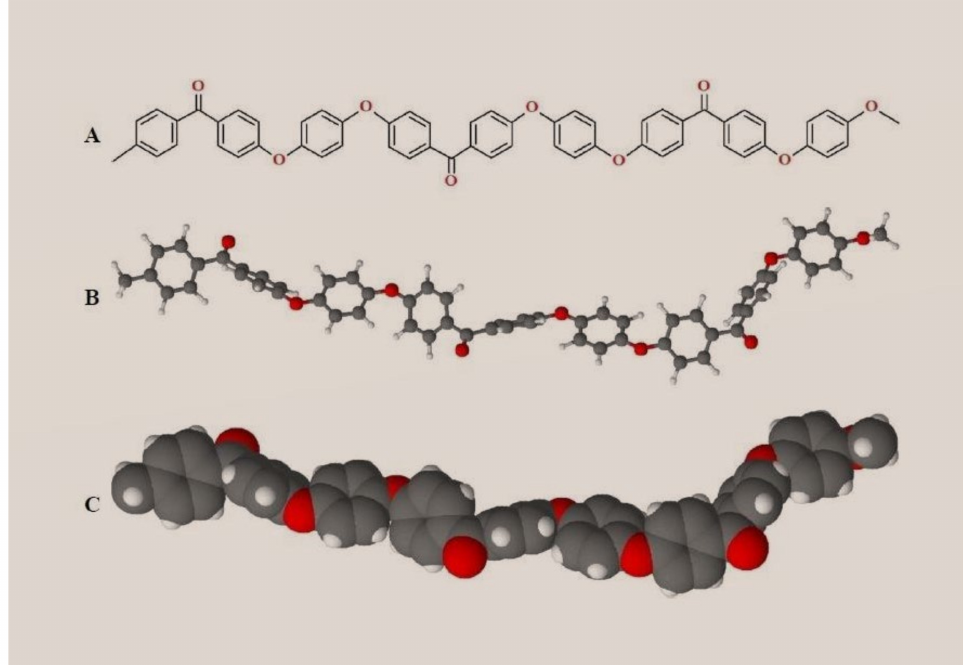
Figure 2. PEEK (polyether ether ketone) molecular structure, ( A ) phenylene rings (aryl), ( B ) oxygen bridges (R-O-R), ( C ) carbonyl groups